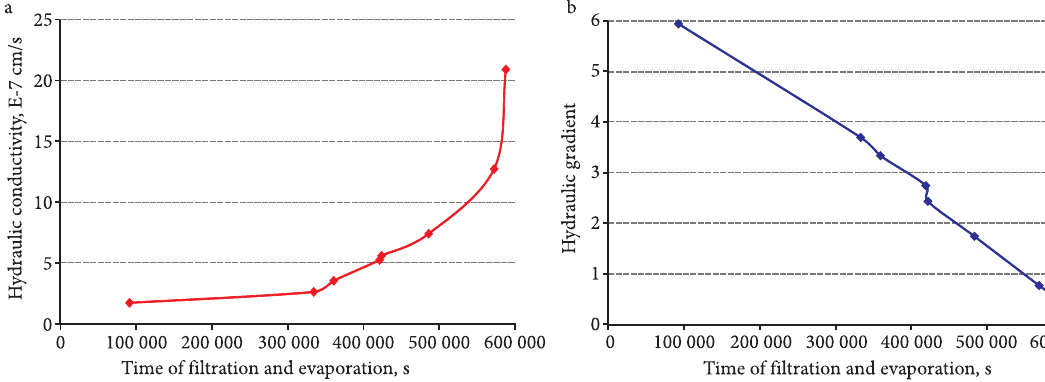
Fig. 5. Results of simultaneous filtration and evaporation experiment (the sample surface uncovered): a – hydraulic conductivity dependence on time; b – hydraulic gradient dependence on time